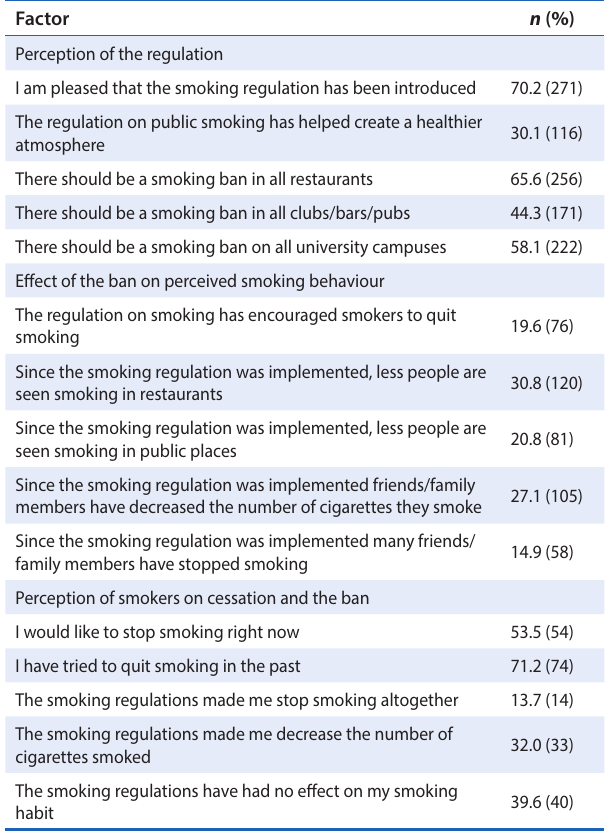
Table 3: Attitudes towards the smoking policy Factor n ( % ) Perception of the